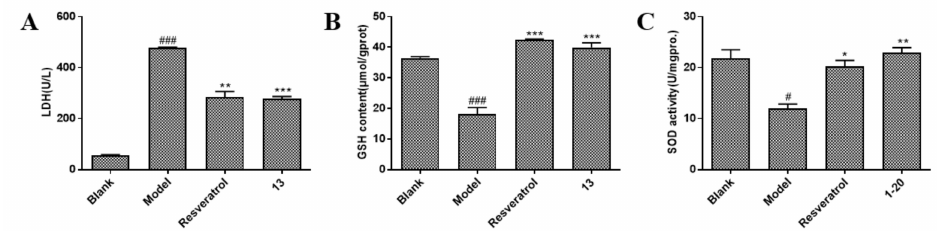
Figure 5. Compound 13 attenuated H/R-induced cell injury and oxidative stress in H9c2 cells. ( A ) Cell injury was determined by measuring LDH (lactate dehydrogenase) release in H9c2 cells under H/R treatment. ### p < 0.001 vs. blank. ** p < 0.01, *** p < 0.001 vs. model. ( B ) Oxidative stress was evaluated by measuring GSH (L-Glutathione) content in cell supernatants. ### p < 0.001 vs. blank. *** p < 0.001 vs. model. ( C ) Oxidative stress was also evaluated by measuring SOD (superoxide dismutase) activity in cell supernatants. # p < 0.05 vs. blank. * p < 0.05, ** p < 0.01 vs. model.